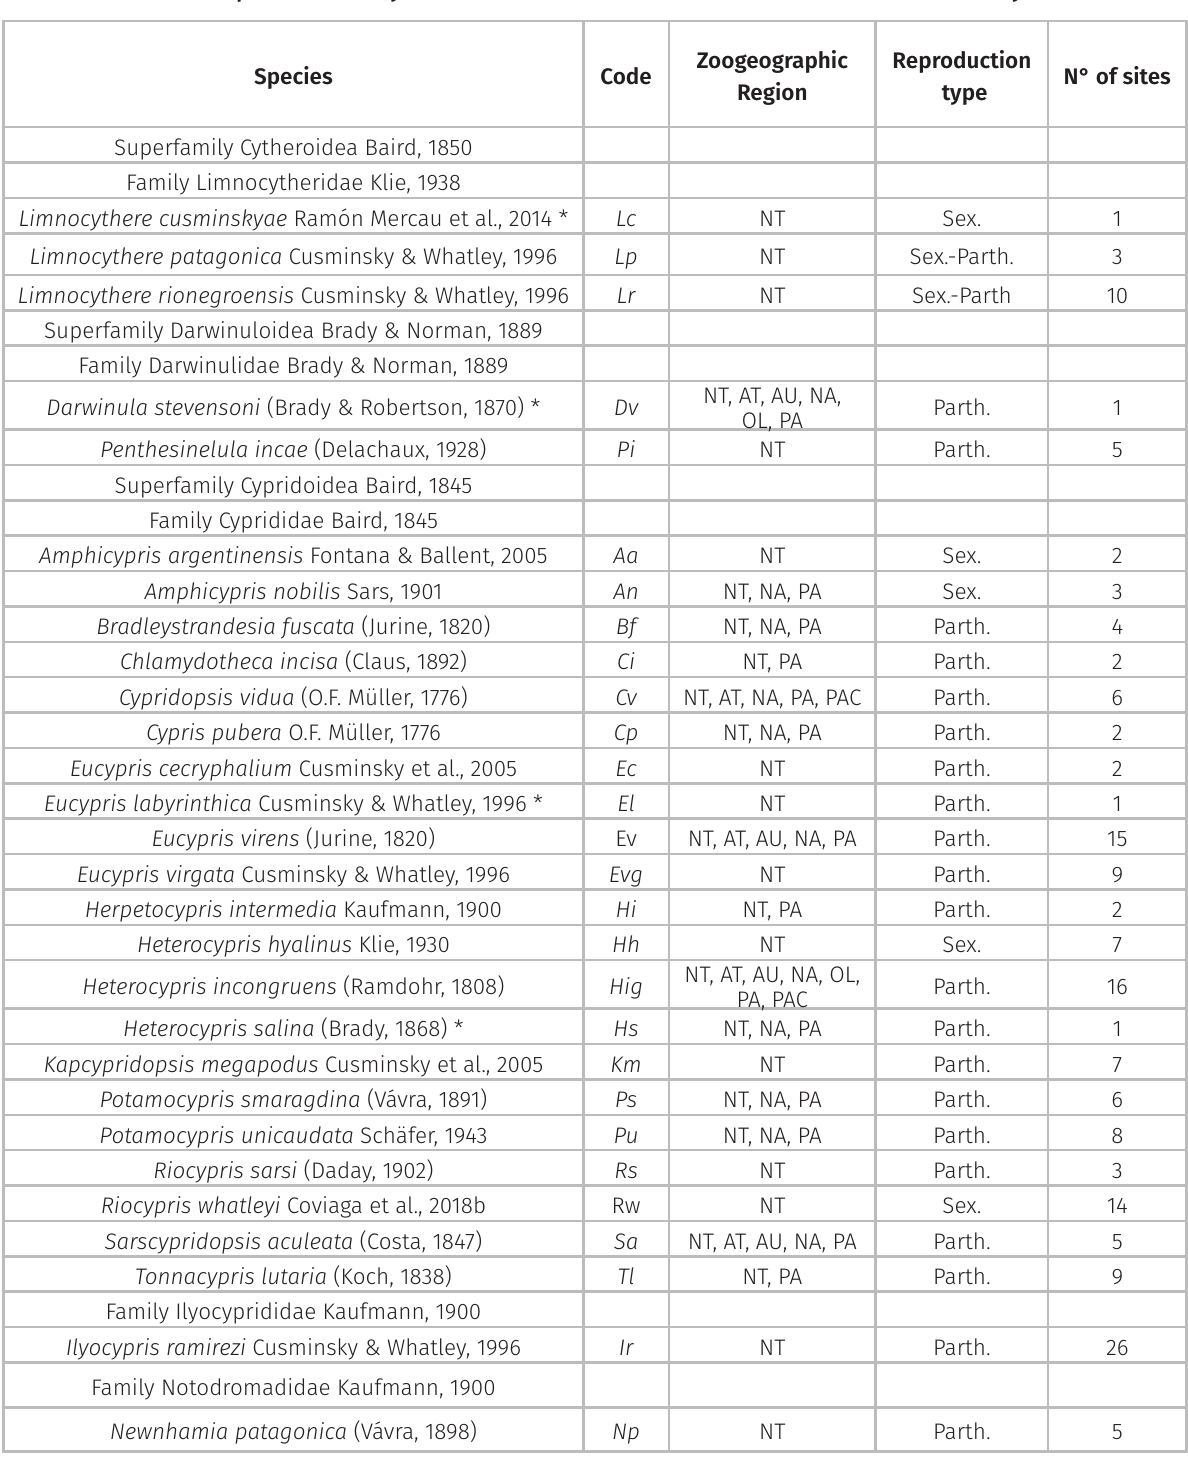
Table II. List of identified ostracods and their occurrence in the study area (codes of sampling sites as in Table SI). Abbreviations: NT = Neotropical; AT = Afrotropical; AU = Australasian; NA = Nearctic; PA = Palaearctic; OL = Oriental; PAC = Pacific Oceanic Island; Sex. = sexual; Sex.-Parth. = sexual and parthenogenetic; Parth. = parthenogenetic. An asterisk denotes the species with only one occurrence that were excluded from the statistical